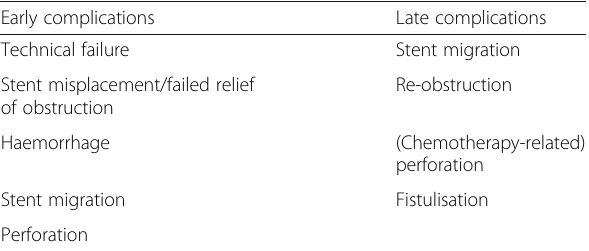
Table 2 Complications after stent placement in the management of colorectal